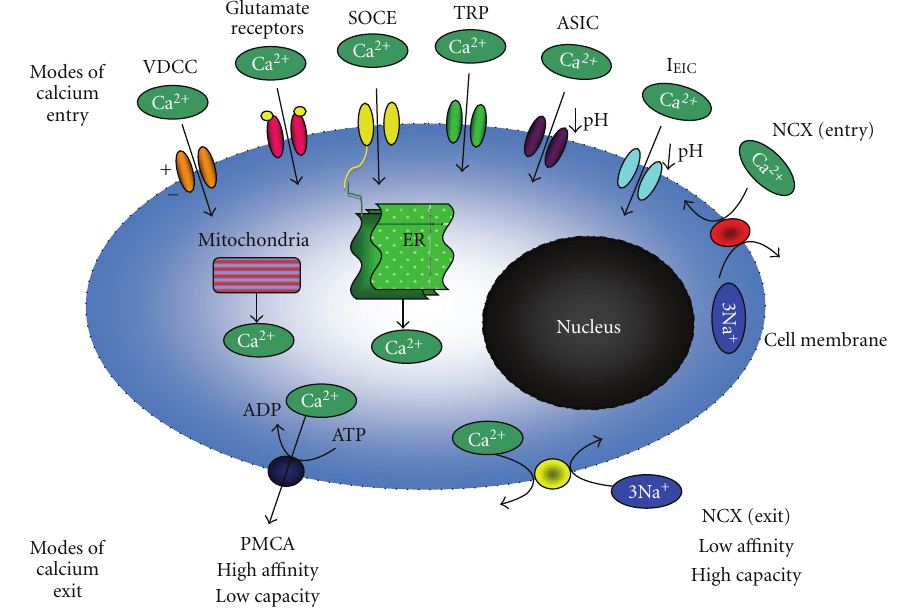
Figure 1: Modes of calcium entry and exit into neurons following cerebral ischemia. Modes of calcium entry (top of cell diagram) are VDCCs (voltage-dependent calcium channel), glutamate receptors (NMDA, AMPA, KA, and mGluR), SOCE (store-operated intracellular calcium entry), TRP (transient receptor potential channels), ASIC (acid-sensing ion channels), I EIC (inward excitotoxic injury current calcium- permeable channels), and NCX (sodium-calcium exchanger operating in entry mode). Calcium can also be sequestered intracellularly (middle of cell diagram) by the mitochondria and ER (endoplasmic reticulum). Modes of calcium exit (bottom of cell diagram) are PCMA (Calcium ATPase pump) and NCX (sodium-calcium exchanger operating in exit